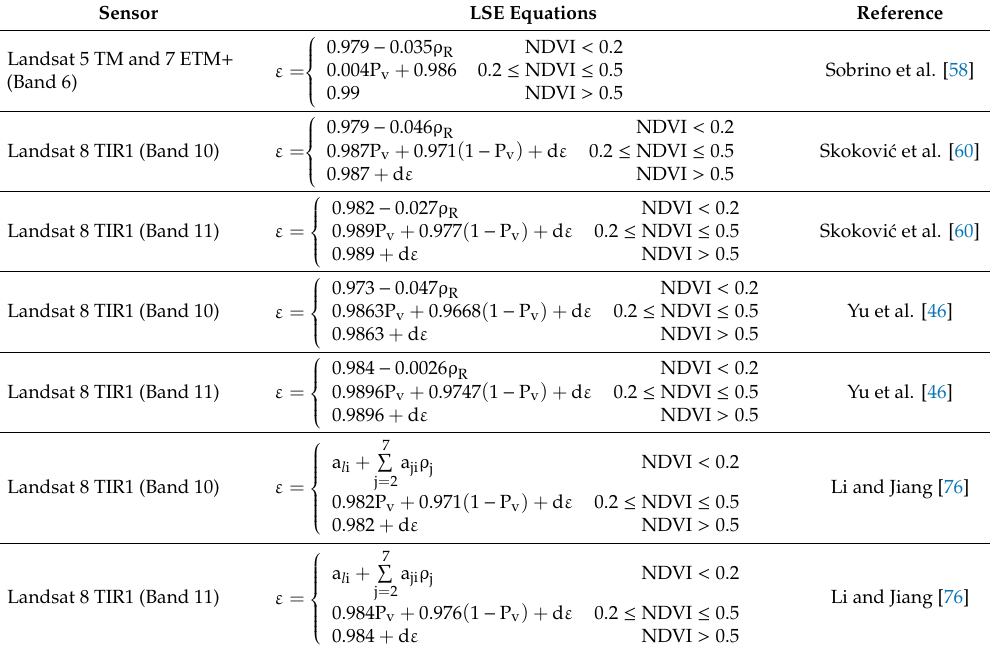
Table 4. The expressions of Normalized Di ff erence Vegetation Index (NDVI) threshold models used in this